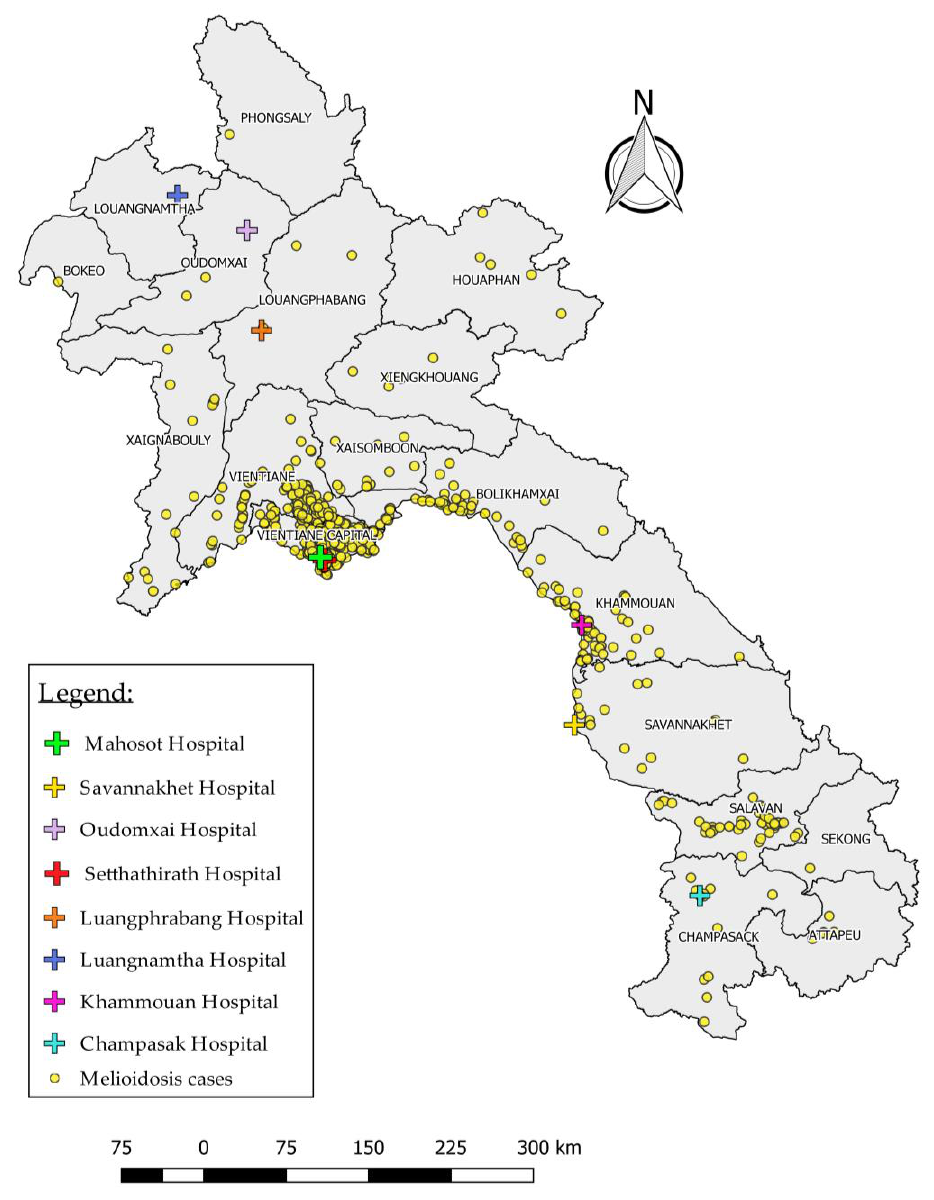
Figure 1. Location of homes of 1310 cases of melioidosis and hospital laboratories capable of making a diagnosis of melioidosis in Laos (data only available for 1310 of 1359 cases).